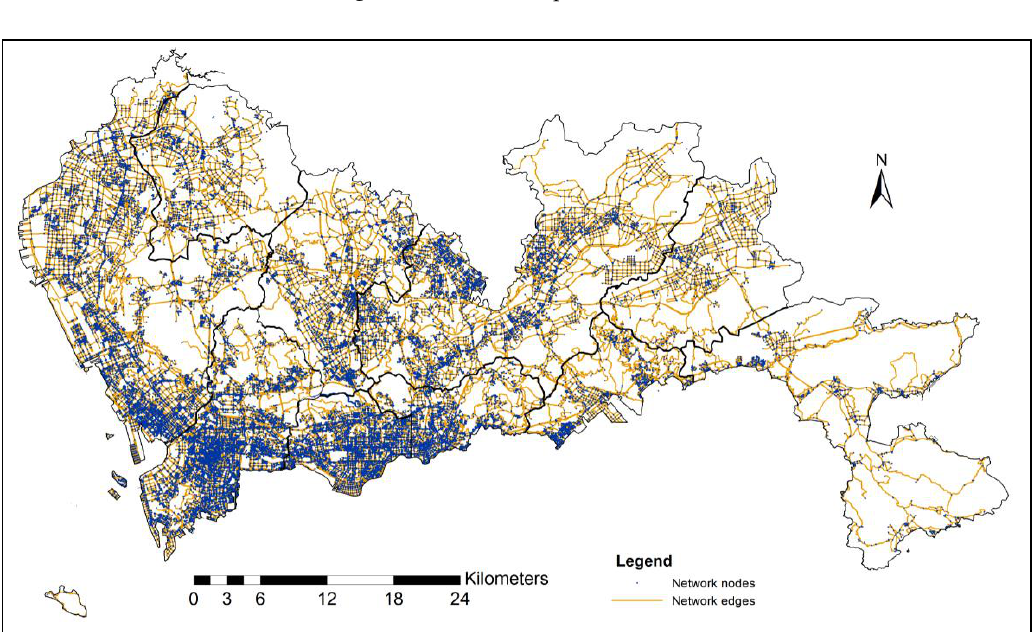
Figure 1. Location map of Shenzhen. ISPRS Int. J. Geo-Inf. 2020 , 9 , x